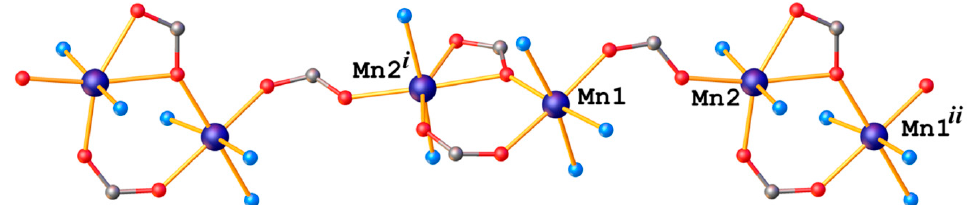
Figure 3. The 1D arrangement of metal ions, highlighting the coordination functions of the